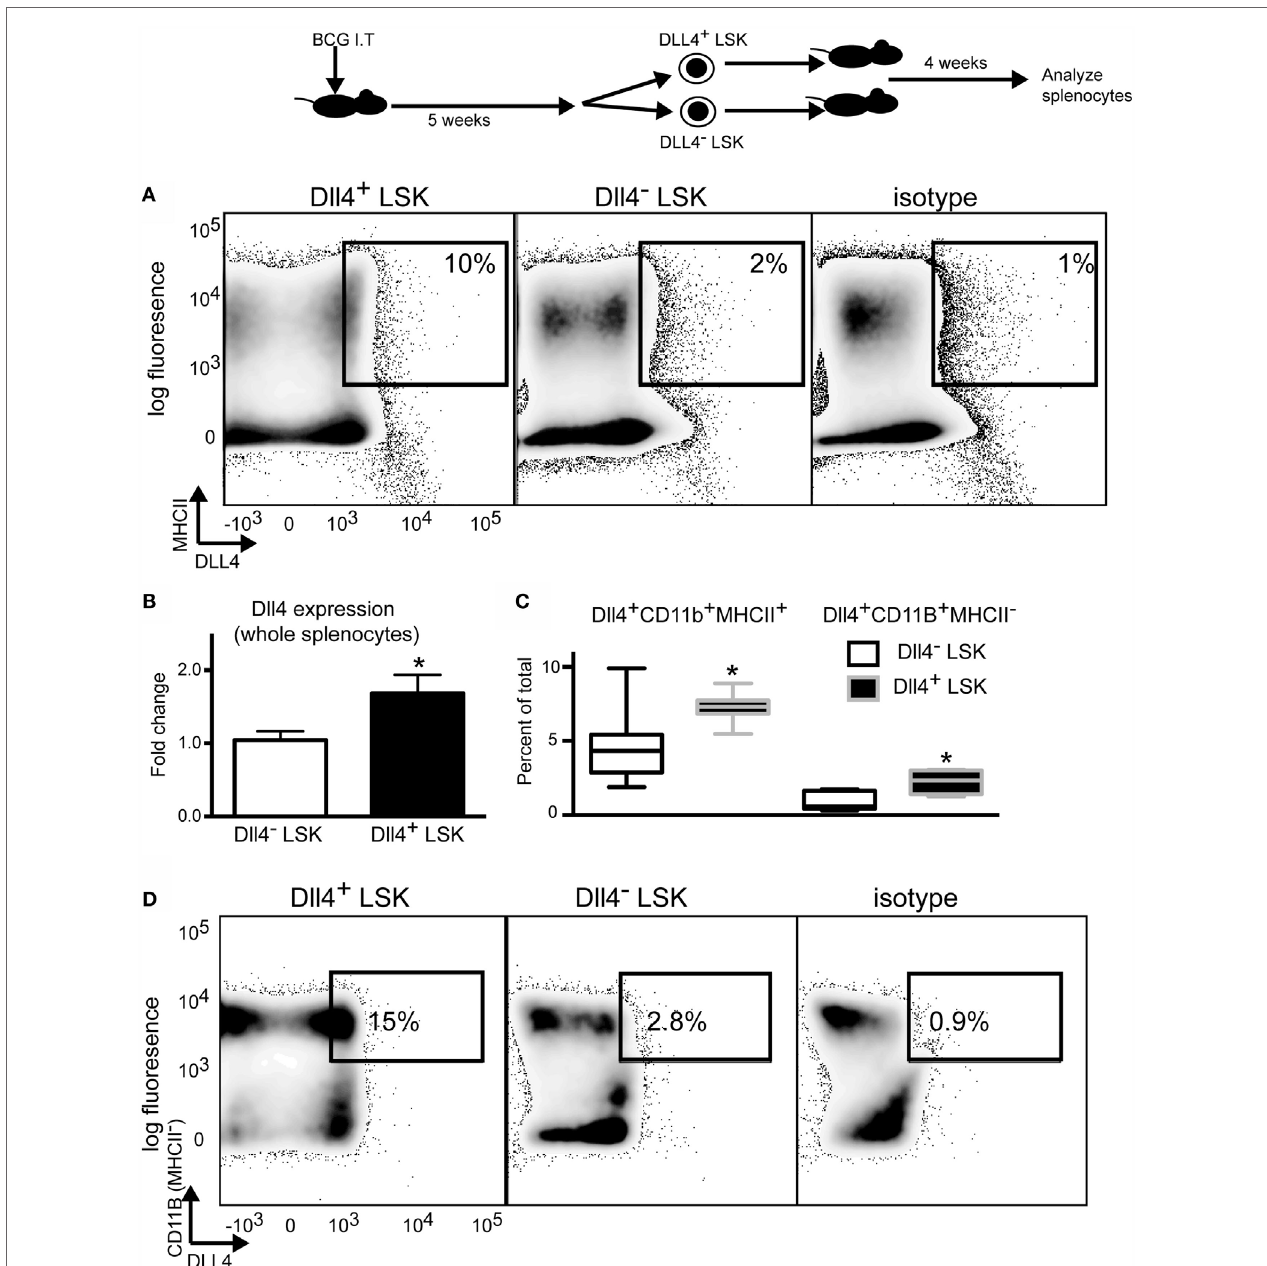
FigUre 2 | Delta-like 4 expression is maintained during short-term hematopoiesis . (a) Flow cytometry plots depicting dll4 and MHCII staining in total splenocytes from recipient chimera mice 4 weeks post-engraftment. Donor cells were either dll4 + LSK or dll4 − LSK cells isolated from mice infected with 5.0 × 10 5 cells at 5 weeks post-infection. Each mouse received 5.0 × 10 4 LSK cells. (B) QPCR analysis of whole splenocytes for dll4 expression at 4 weeks post-engraftment. N = 4 mice per group, and the experiment was repeated two times. (c) Quantification of dll4 expression on B220 − CD11B + MHCII + and B220 − CD11B + MHCII − in the spleens of chimeric mice. N = 4 mice per group. (D) Flow plots depicting expression of dll4 on B220 − CD11B + MHCII − cells as quantified in (c) . Gates indicate percent of B220 − CD11B + MHCII − cells expressing DLL4. For (B,c) , Student’s t -test was performed (* p < 0.04). These experiments were repeated two